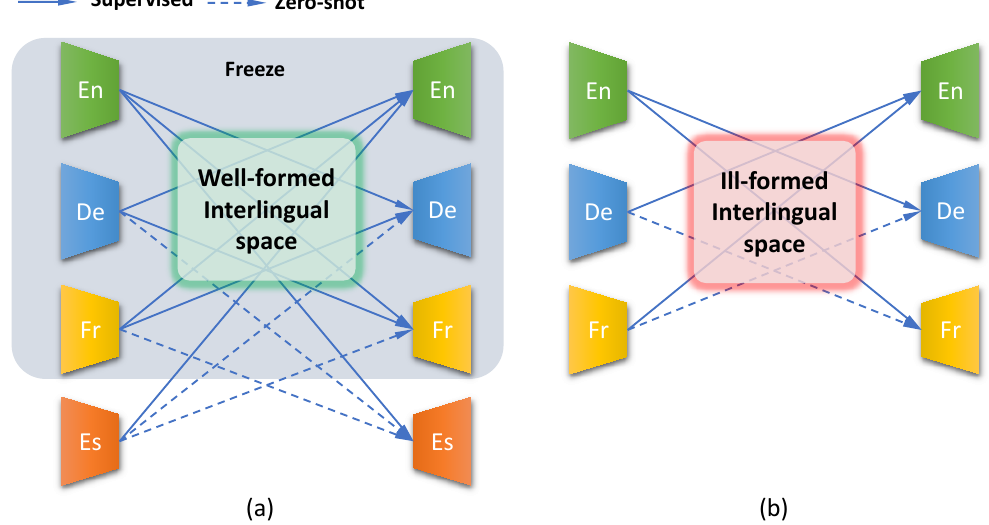
Figure 3. Interlingual space formed by training in the M2M and JM2M environments. ( a ) The well-formed interlingual space in the M2M environment enables zero-shot translation in the in- cremental learning stage. ( b ) The ill-formed interlingual space in the JM2M environment disables zero-shot